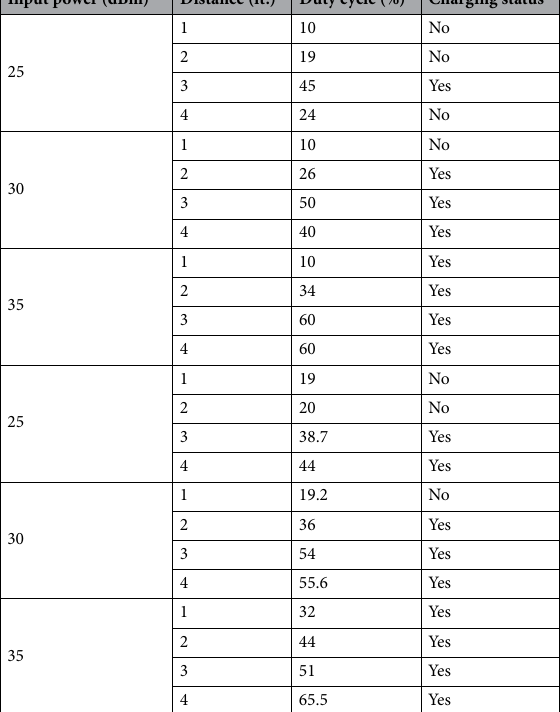
Table 2. Recording the duty cycle for varying wireless charging for the cases with varying distances between the Tx and Rx, and with varying input RF power using 5 Tx antennas (first 3 rows for Input power) and 10 Tx antennas (last 3 rows for Input power). The output voltage pulses were in the range of 4.2 to 5.5 V for all